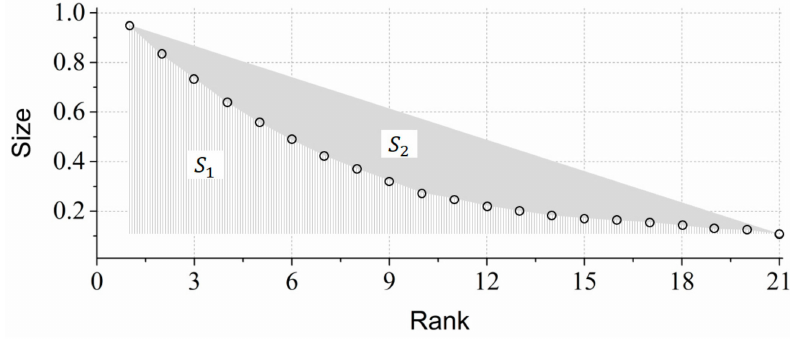
Figure 4. Two polygons constructed for computing the RA index of a